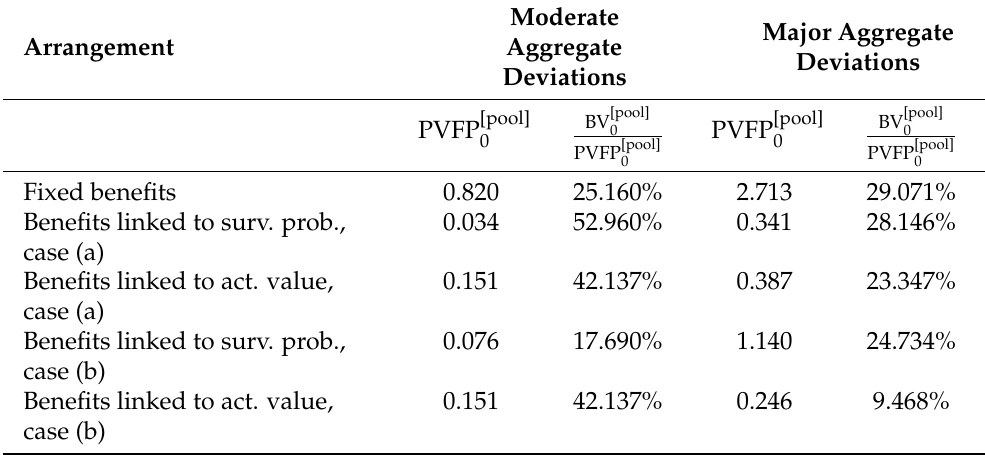
Table 6. Present Value of Future Profits and Business Value (expected values), at time